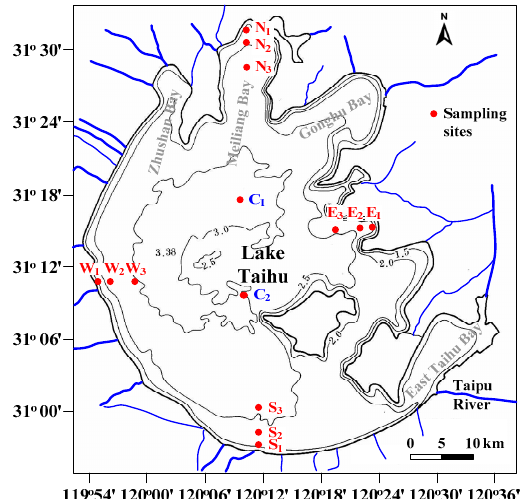
Figure 1. Main rivers (blue lines) surrounding Lake Taihu and sampling sites (red dots) of surface water and the hyporheic zone.